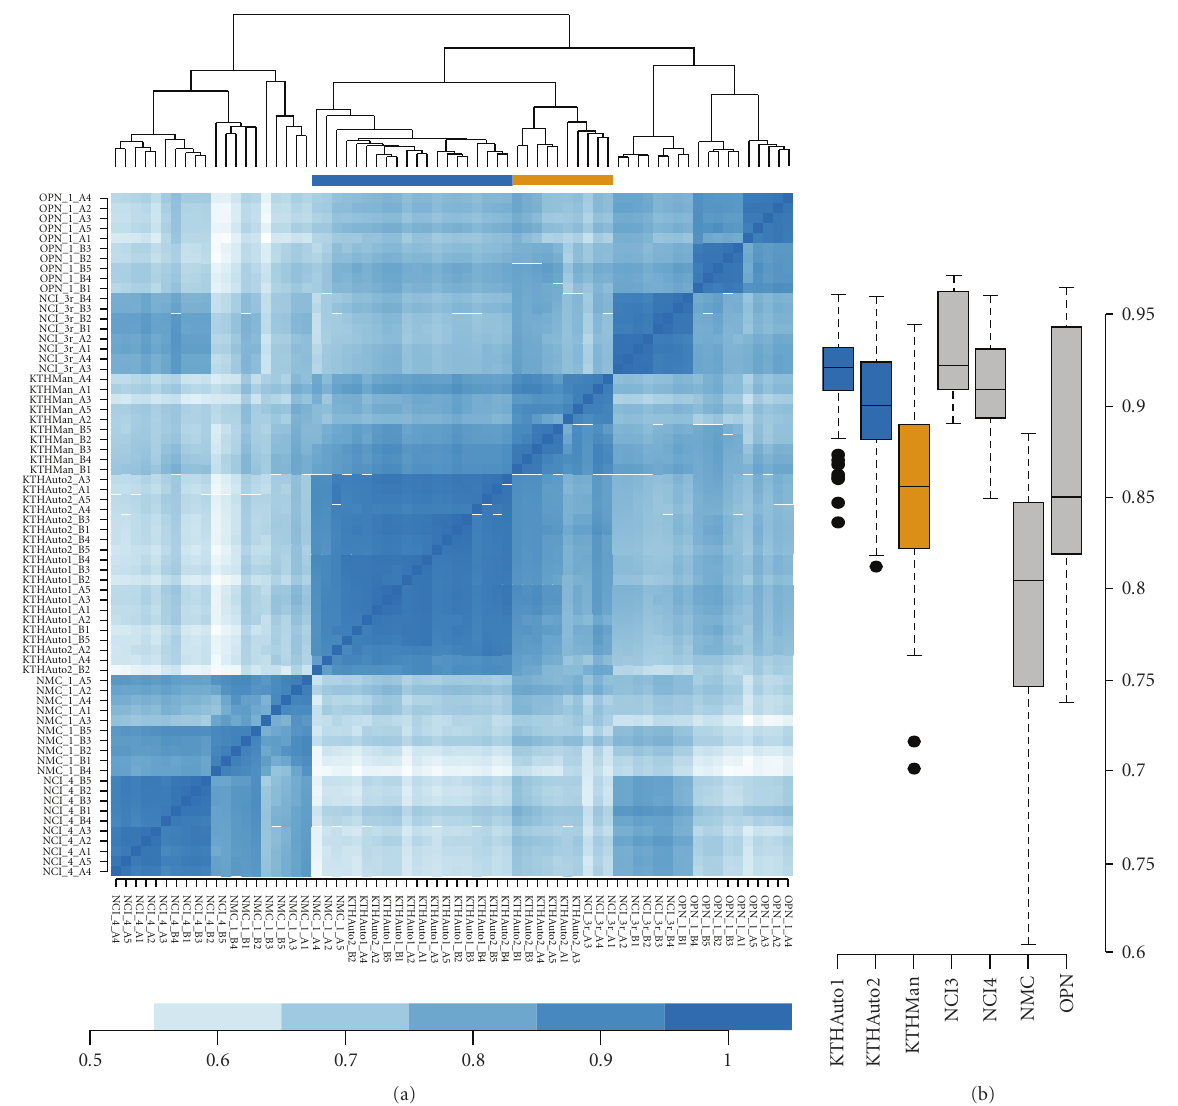
Figure 3: Automation of cDNA synthesis and labelling produces a higher correlation between technical replicates. (a) Dendrogram and heatmap of Spearman’s rank correlation between manually labelled (gold cluster, KTH Man) and automatically labelled (blue cluster, KTH Auto1, and KTH Auto2) samples. (b) Boxplot of the well-to-well reproducibility within experiments. Automatically labelled samples (blue boxes) are more highly correlated than manually labelled samples (gold box). Our automated approach also exhibited a higher correlation than between NMC and OPN experiments, but not higher than between the two NCI